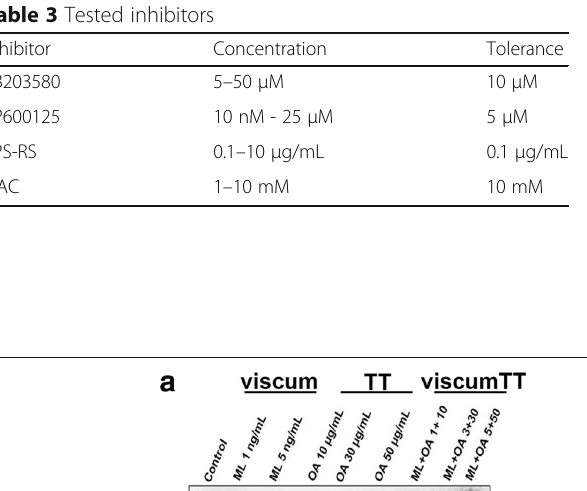
antioxidant, N-acetylcysteine (NAC, 5 mM). Apoptosis was flow cytometrically assessed following annexin V/propidium iodide staining. Bars show